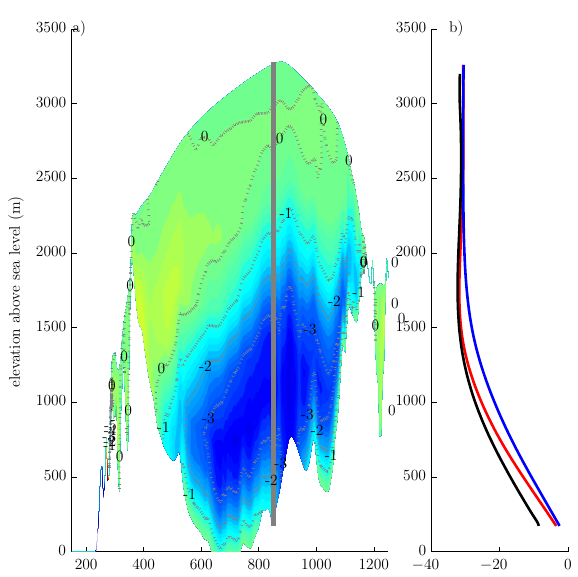
Figure 7. (a) Difference in final preindustrial temperature across the central ice sheet between transient and equilibrium spin-up simula- tions (blue: transient simulation is colder); (b) comparison of ver- tical temperature profiles at observed summit location to the GRIP temperature profile. Red: transient spin-up; blue: equilibrium spin- up; black: GRIP temperature profile.